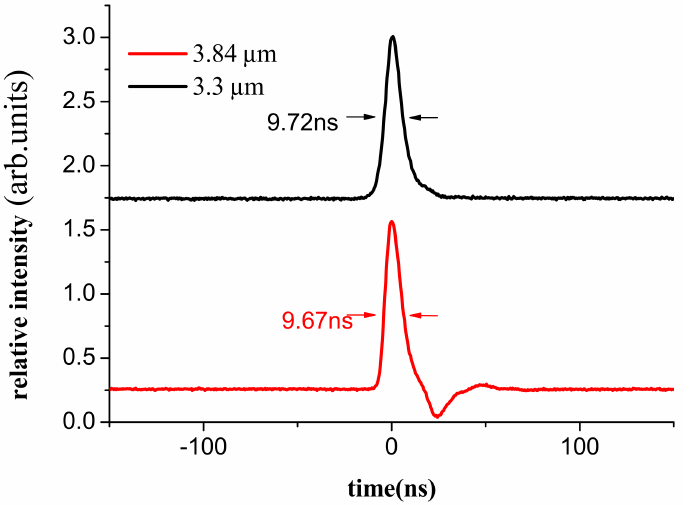
Figure 9. Pulse width of the mid-infrared